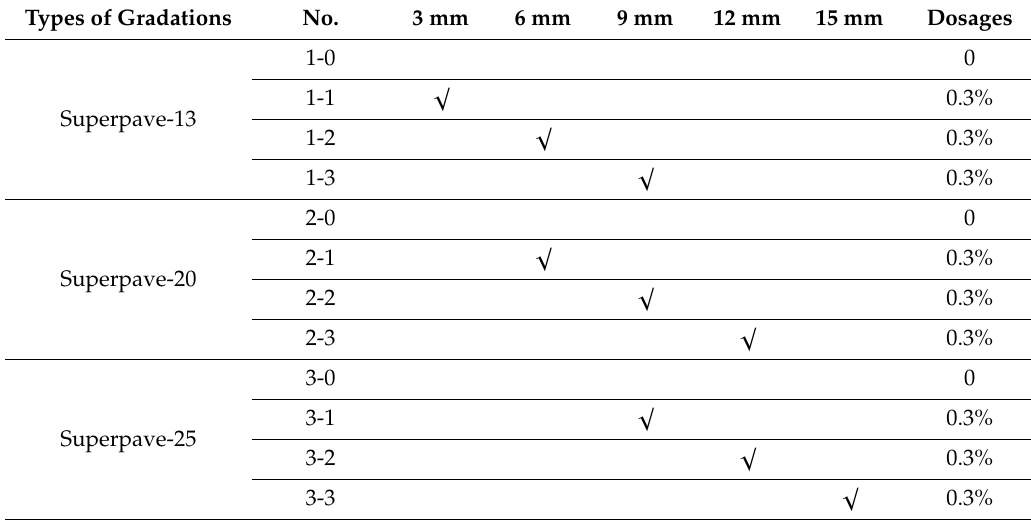
Table 4. Labeling of the asphalt mixture with a single length of basalt